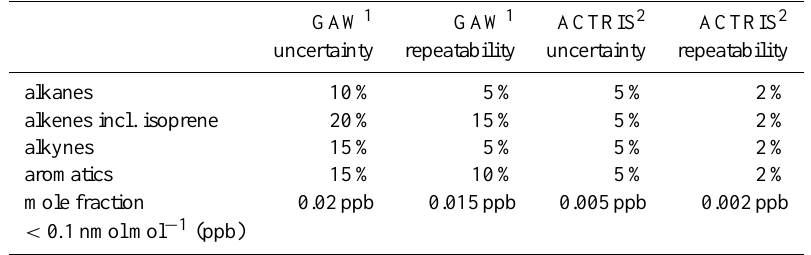
Table 2. ACTRIS and former GAW 1 data quality objectives (DQOs). Numbers express the expanded uncertainty (coverage factor k = 2), and the repeatability (standard